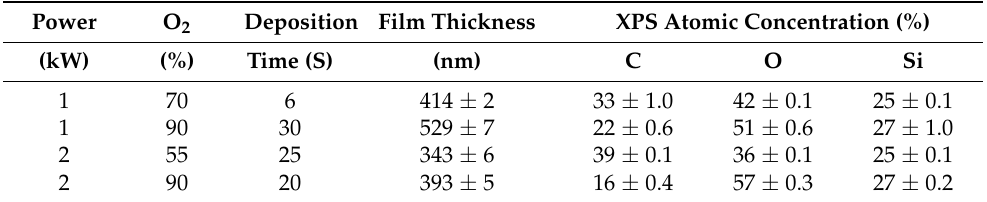
Table 3. Film thicknesses and XPS atomic concentrations of MW TMDSO films deposited at varying powers and O 2